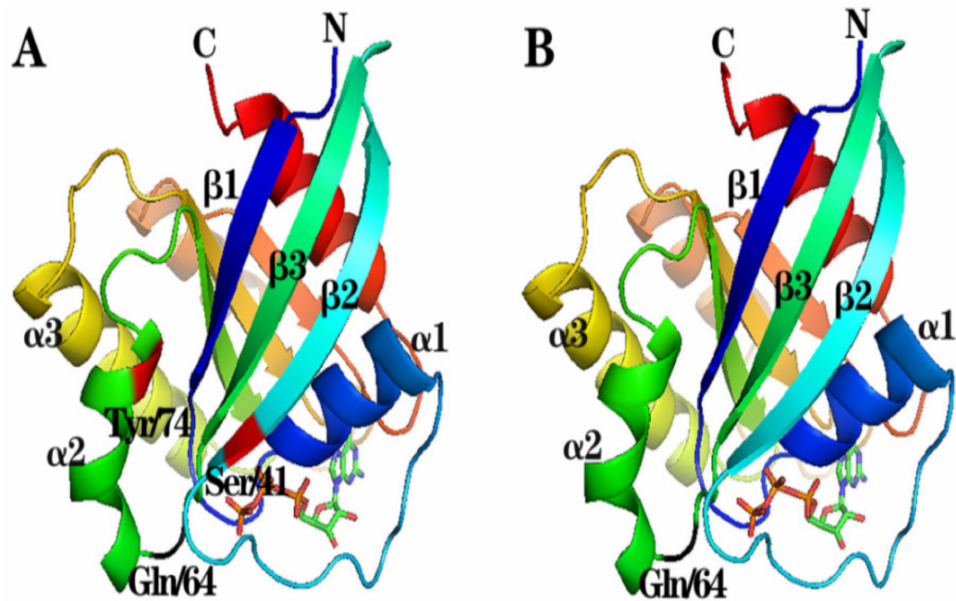
Figure 2. ( A ) 3D protein structures of cRab22a and ( B ) 3D protein structures of mRab22a. Red-labeled Ser41 and Tyr74 are the mutated amino acid sites, black labeled Gln64 is the GTP-binding